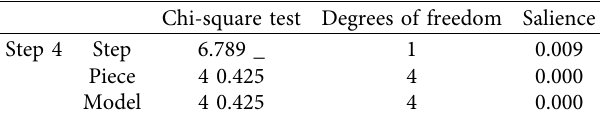
Table 19: Comprehensive test of model coefficients.